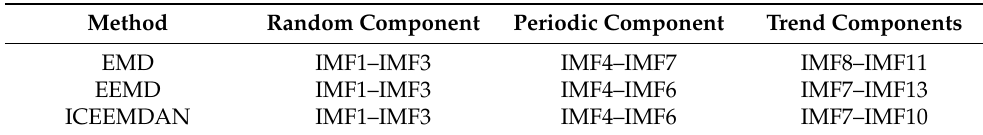
Table 2. Division of three components by different decomposition